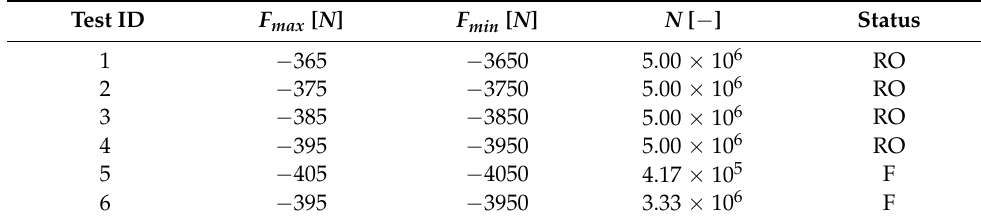
Table 3. Test results relative to the 2 mm-module gear.